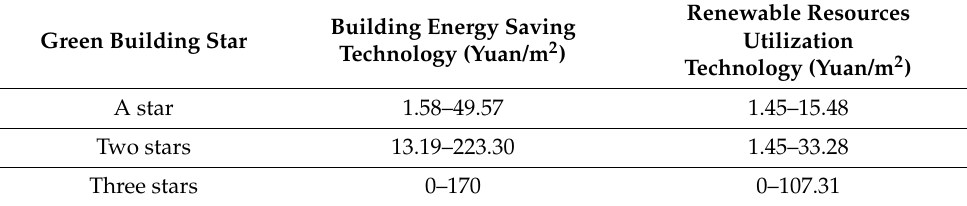
Table 1. Gain cost of energy-saving single